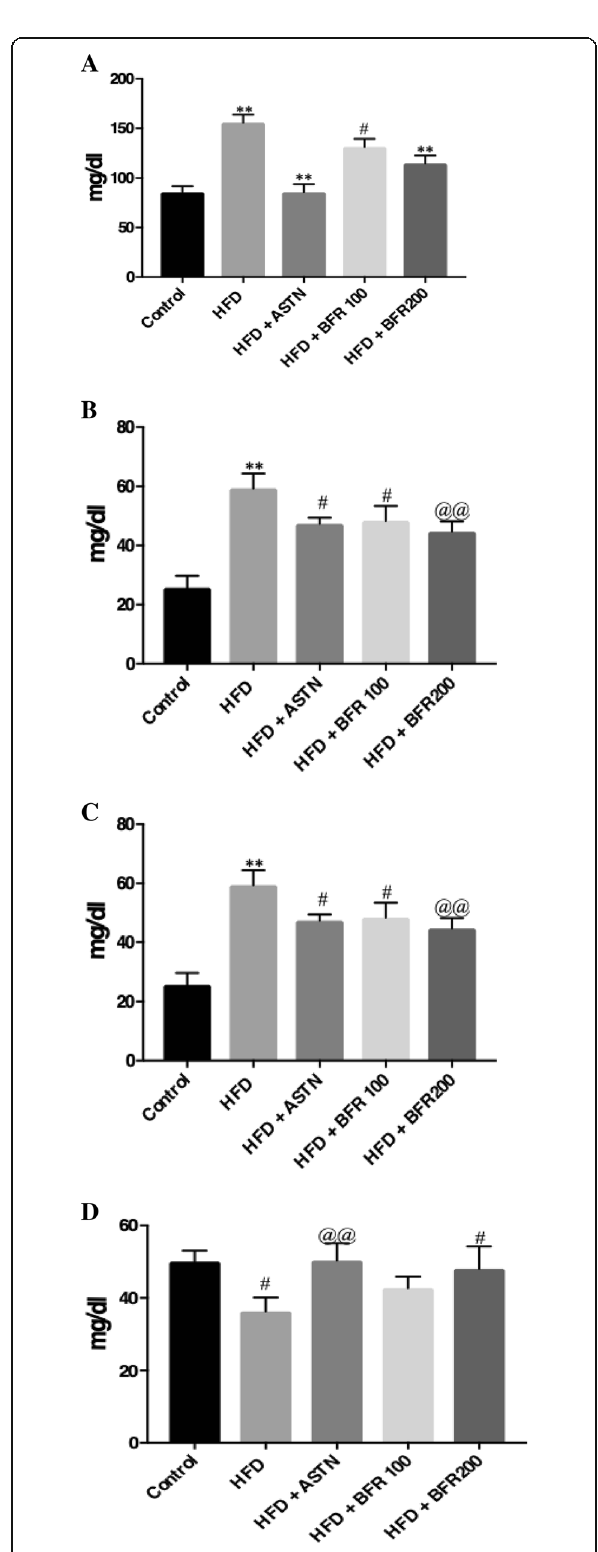
Fig. 3 a Effect of BFR and ATSN in total cholesterol level of the high-fat diet-fed rats. Data were expressed as mean ± SD. Comparison made between HFD vs control and HFD + ATSN vs HFD group, HFD + BFR vs HFD. Statistical significance at # p < 0.05 and ** p < 0.01. b Effect of BFR and ATSN in low-density lipoprotein (LDL) level of the high-fat diet-fed rats. Data were expressed as mean ± SD. Comparison made between HFD vs control and HFD + ATSN vs HFD group, HFD + BFR vs HFD. Statistical significance at #